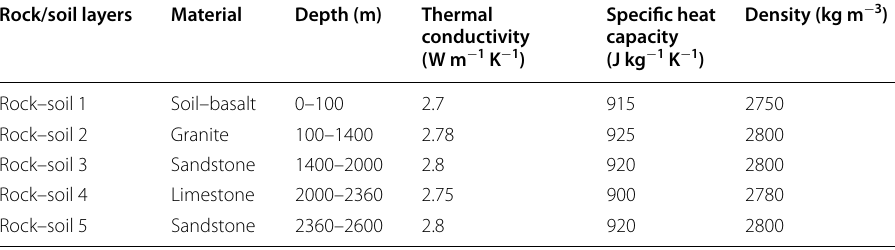
Table 3 Properties of the rock/soil layers Rock/soil layers